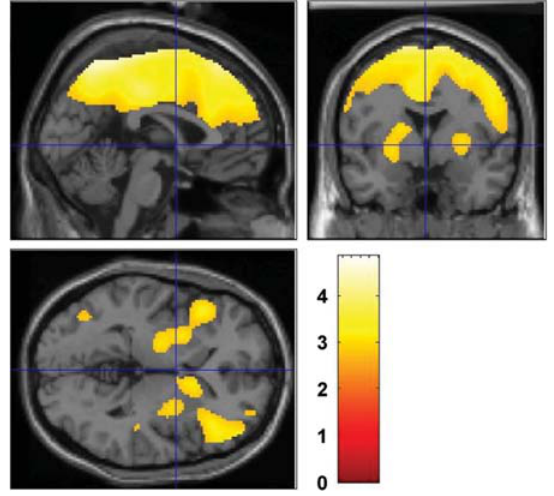
Figure 3. Differences in task activation between placebo (PL) and methylphenidate (MP). SPM results showing the areas that had greater increases in metabolism when the cognitive task was given with placebo versus when it was given with methylphenidate (MP). Comparisons correspond to paired t-tests (p , 0.005 uncorrected . 100 pixels). None of the brain regions had higher metabolism for the cognitive task when given with MP than with placebo.